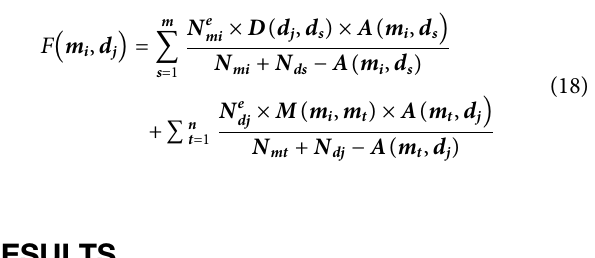
Frontiers in Genetics |